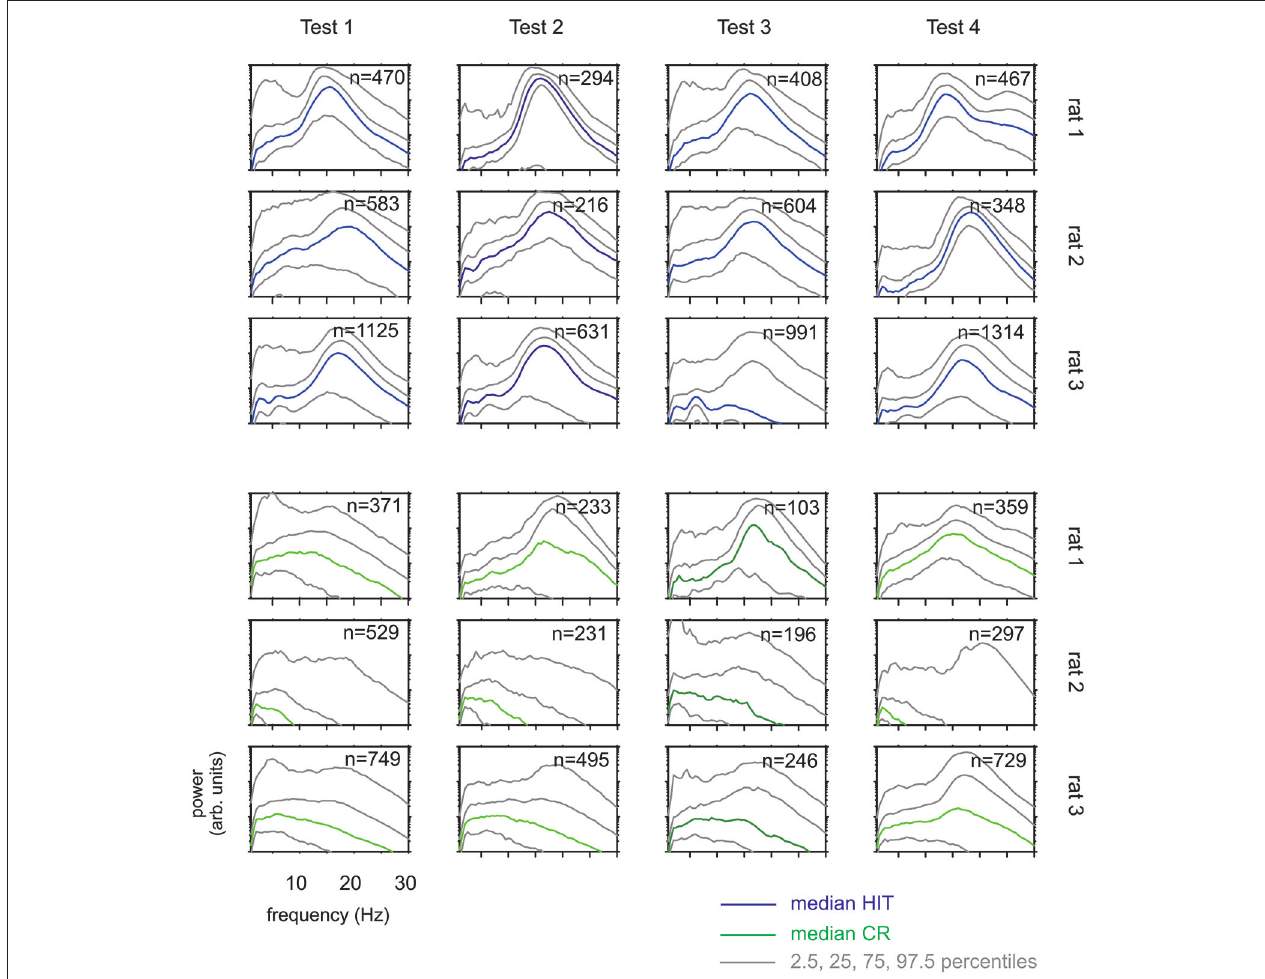
(green, bottom). Shown are the median (colored) and the percentiles as indicated in the legend. There are systematic differences across rats. Across Tests, however, each animal generated similar whisking